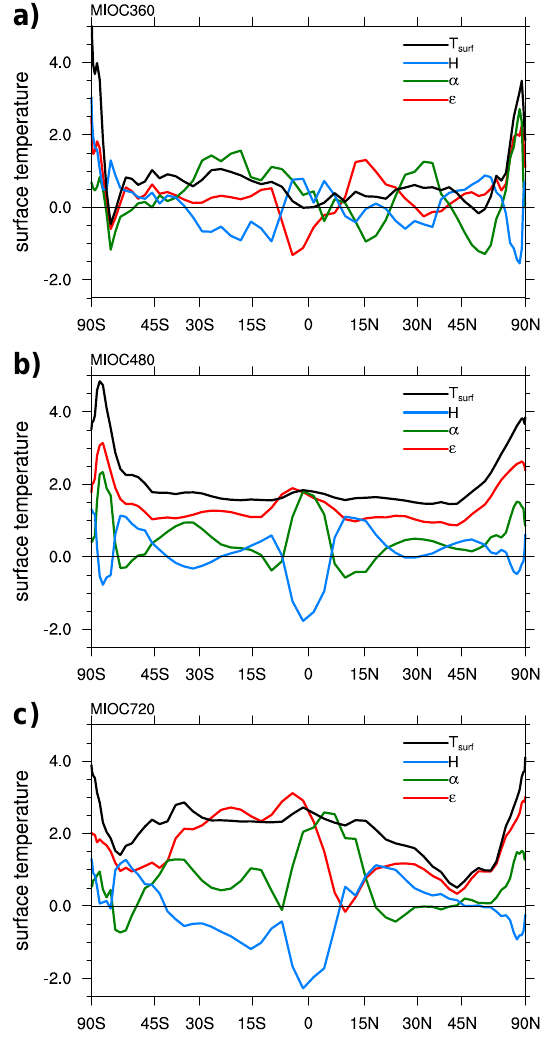
Fig. 6. Contribution of α , (cid:15) , and H to changes in the zonally av- eraged surface temperature T surf according to Eq. (1). Temperature increase in (a) MIOC360 compared to CTRL, (b) MIOC480 com- pared to MIOC360, and (c) MIOC720 compared to